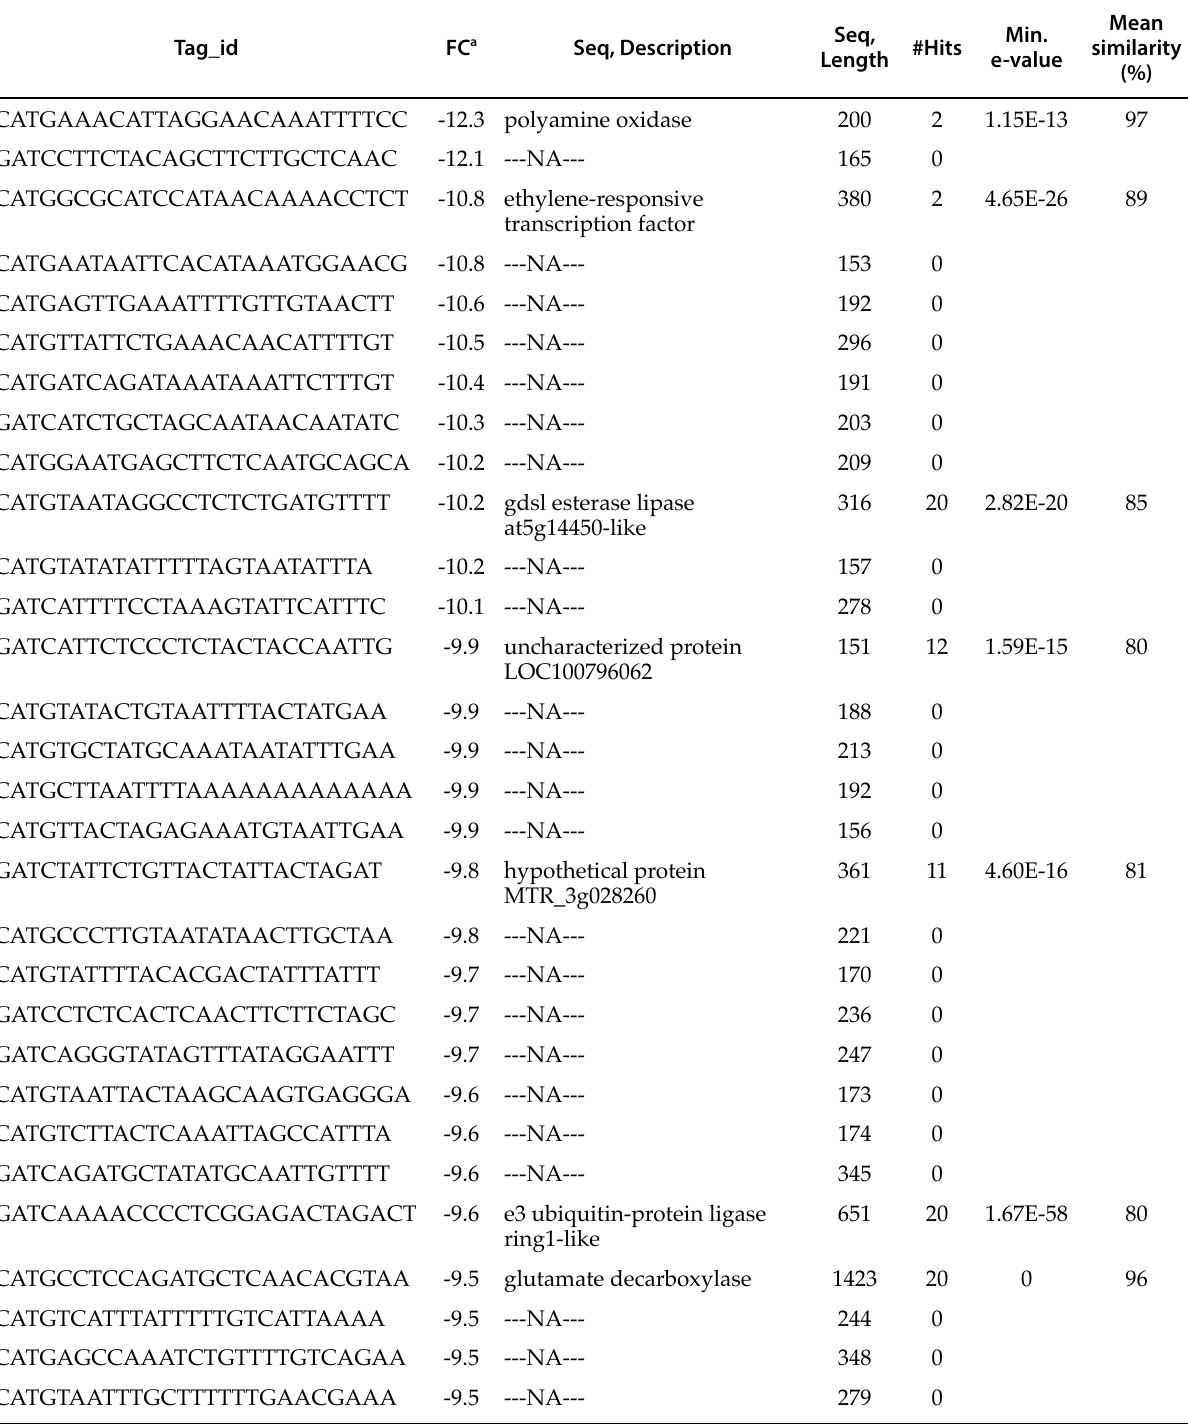
Table 2. Top 40 up-regulated tags.